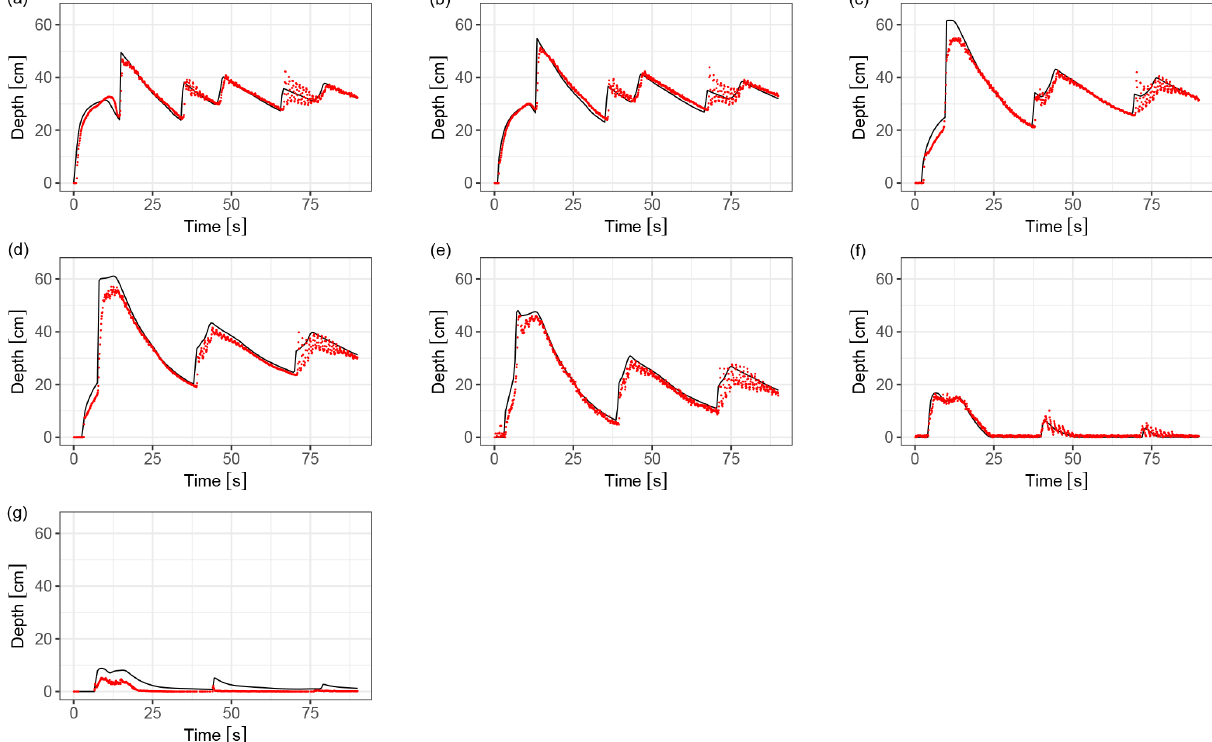
Figure A8. Simulated (black lines) and experimental (red points) transient water depths at seven gauge points ( x = 17.5, x = 19.5, x = 23.5, x = 25.5, x = 26.5, x = 28.5, x = 35.5, from a to b ) for the dam break over a triangular